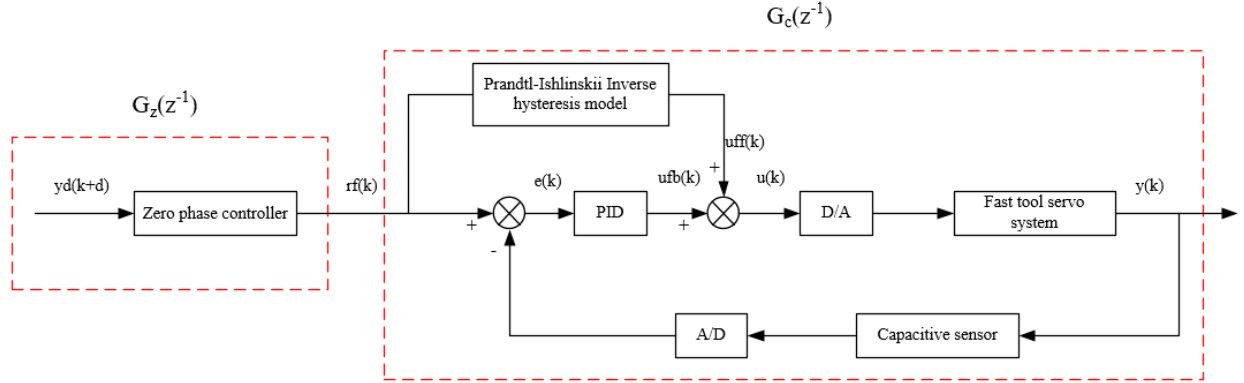
Figure 5. Block diagram of the composite control algorithm.